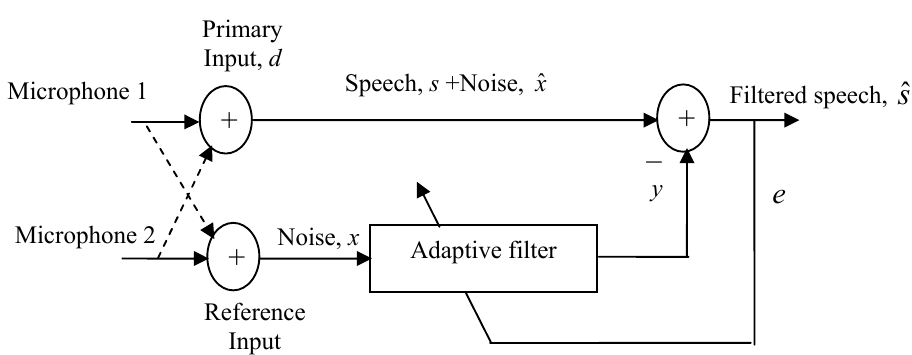
Figure 1. The two-microphone adaptive noise